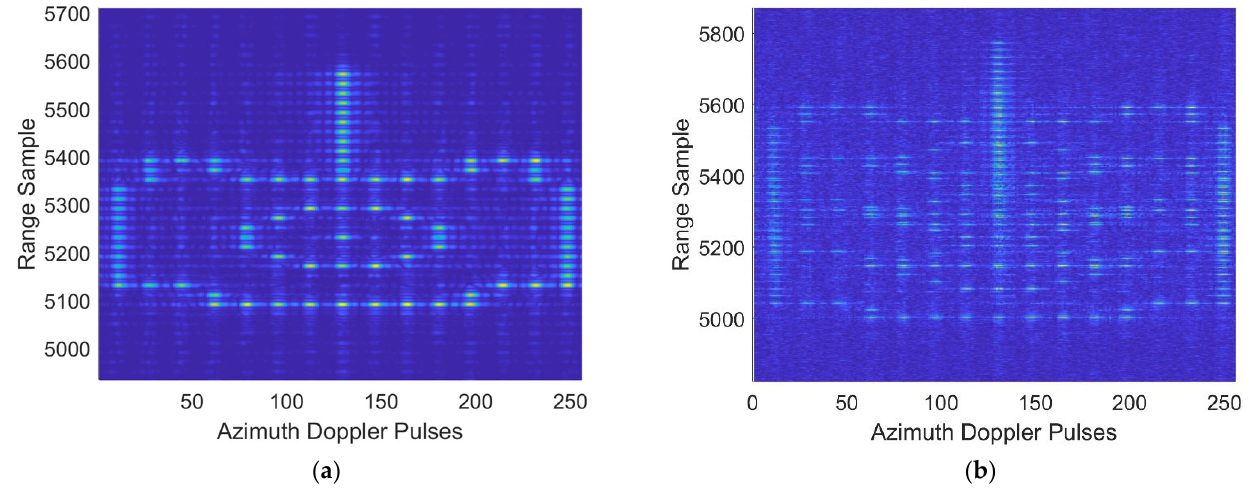
Figure 19. SAR imaging results: ( a ) without jamming; ( b ) SAR jamming result.